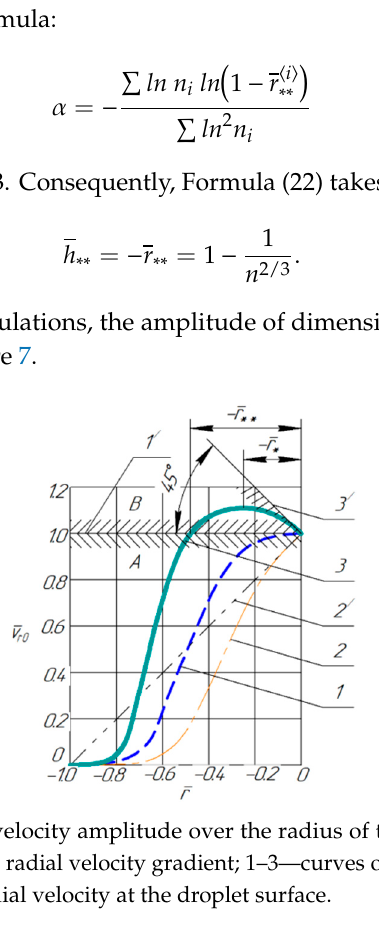
Figure 6. The dependence between the dimensionless radius (cid:1870)̄ ∗∗ and the ratio n .